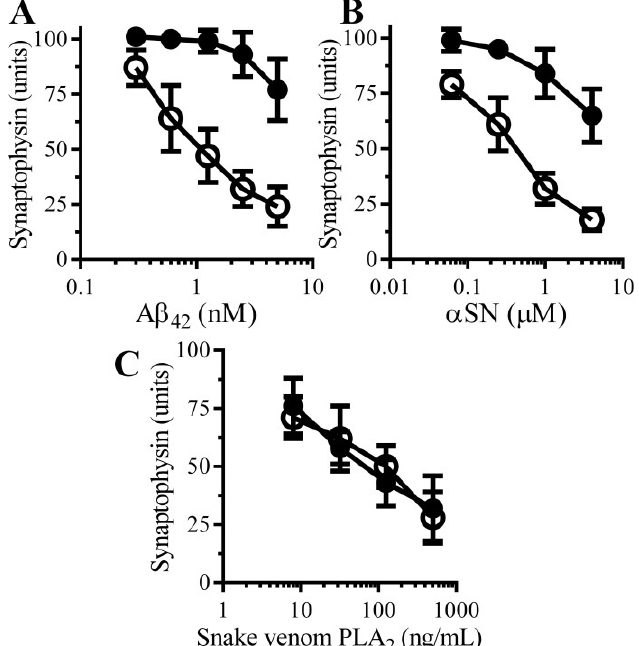
Figure 1. Aβ causes synapse damage in cultured neurons: ( A ) Immunoblots showing the amounts of synapsin-1, VAMP-1 and caveolin in neurons incubated with brain extract as shown; ( B ) The amounts of synaptophysin in neurons incubated with control medium (□), brain extract (■), Aβ-depleted brain extract (striped bar) or mock-depleted brain extract (hatched bar). Values are means ± SD from triplicate experiments performed 2 times ( n = 6). * = synaptophysin significantly less than in control neurons.